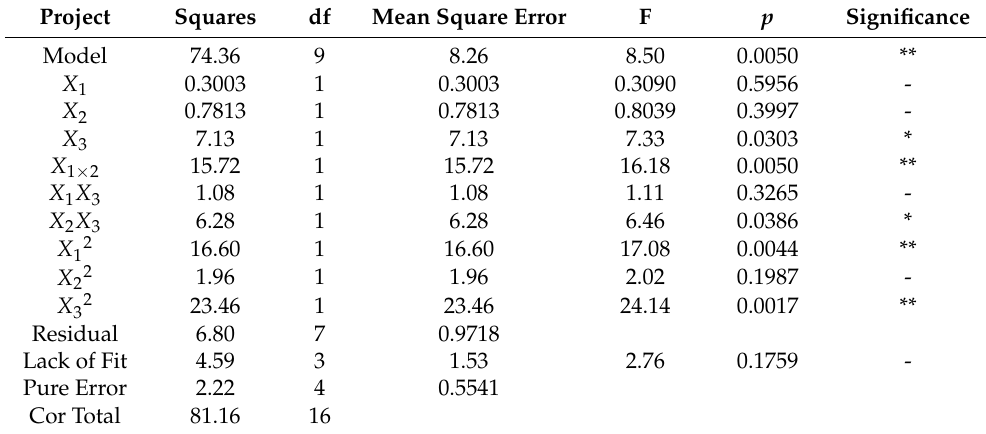
Table 5. Analysis of variance for the cover uniformity back